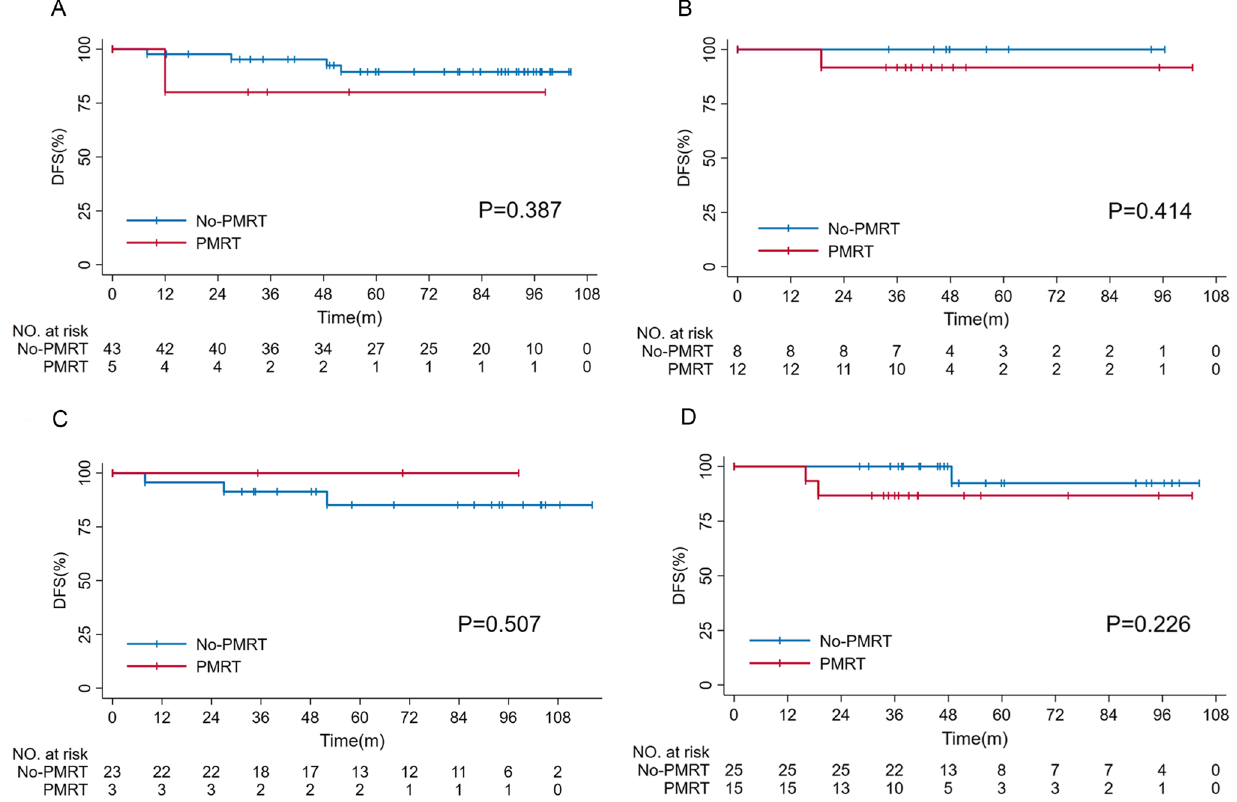
Fig. 3 Kaplan–Meier survival curve for HR( +) and HER2( +) patients with different systemic treatment protocols. A DFS in HR( +) patients without endocrine therapy. B DFS in HR( +) patients with endocrine therapy. C DFS in HER2( +) patients without targeted therapy. D DFS in HER2( +) patients with targeted therapy. Legends: No significant differences in DFS were shown according to delivery of PMRT (all p >